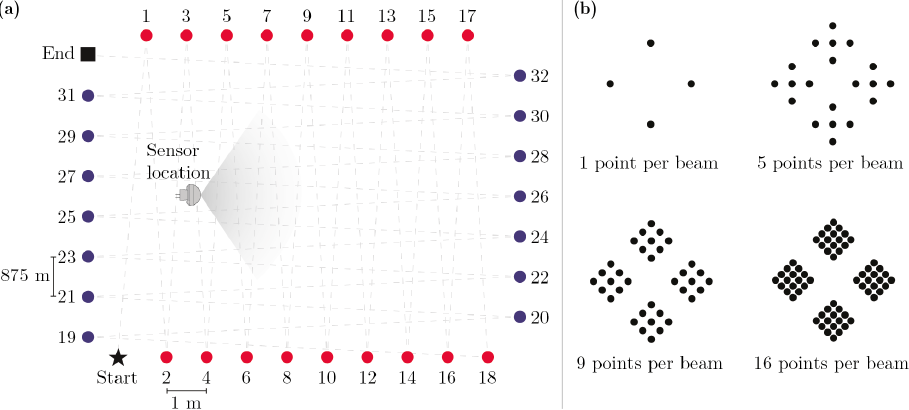
Figure 2. ( a ) rectangular area surrounded by nodes used to test the impact of altering the number of points per beam in the synthetic motion sensor; ( b ) arrangement of rays in the four different point densities